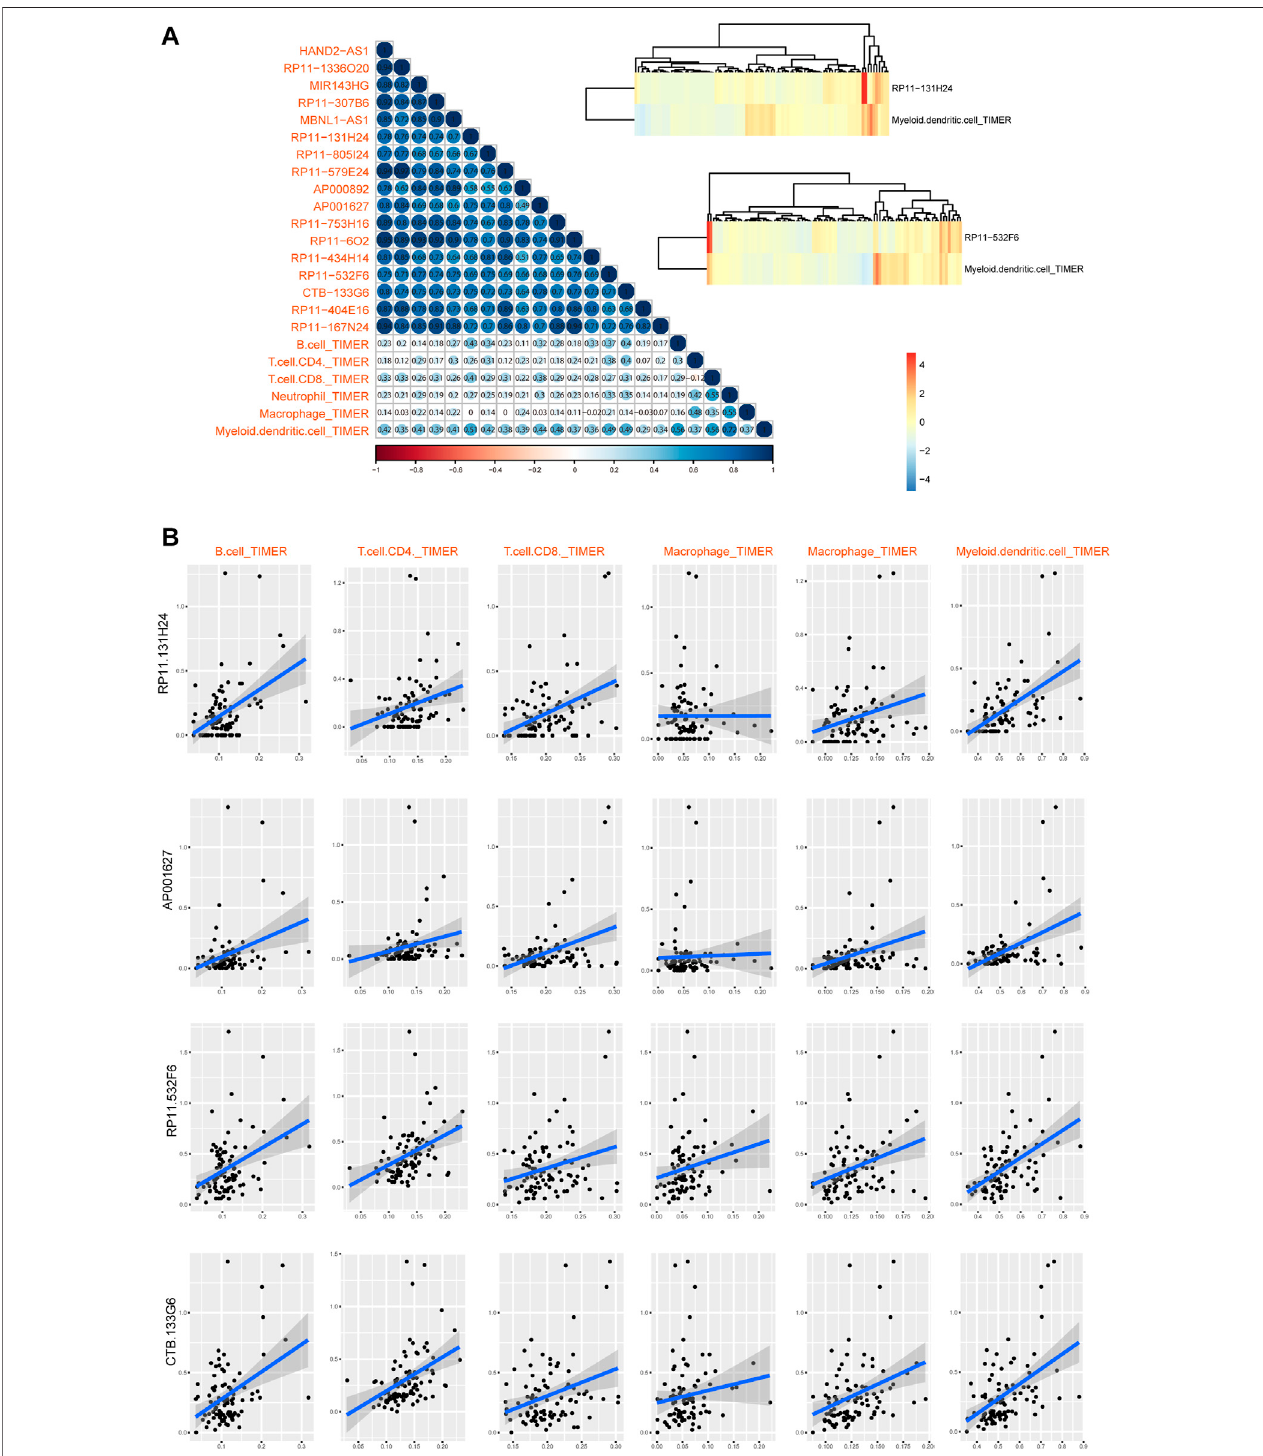
FIGURE 6 | Immune cell in fi ltration of lncRNAs in READ patients. (A) The visualization of correlations between lncRNA expression and TIMER2 immune cell estimation score. Two highest correlation pairs were showed in heatmaps with Cor = 0.52 and 0.49. (B) Scatter plots of correlations between lncRNA expression and TIMER2 immune cell estimation